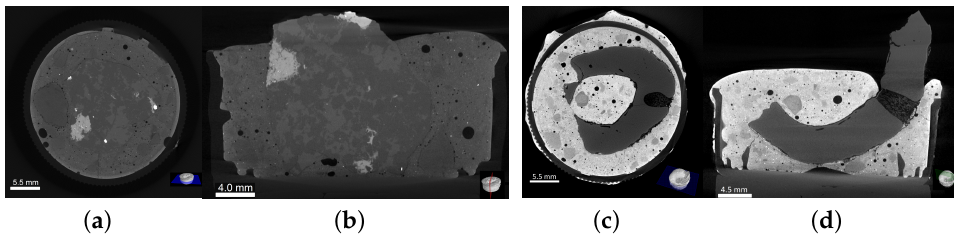
Figure 13. Aggregates embedded in cement paste cylinder: crushed granite’s ( a ) cross- and ( b ) longi- tudinal sections, and crushed endocarp’s ( c ) cross- and ( d ) longitudinal